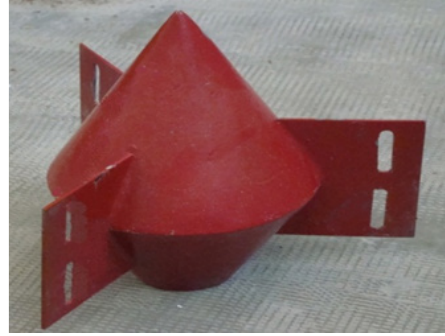
Figure 4: The used insert.